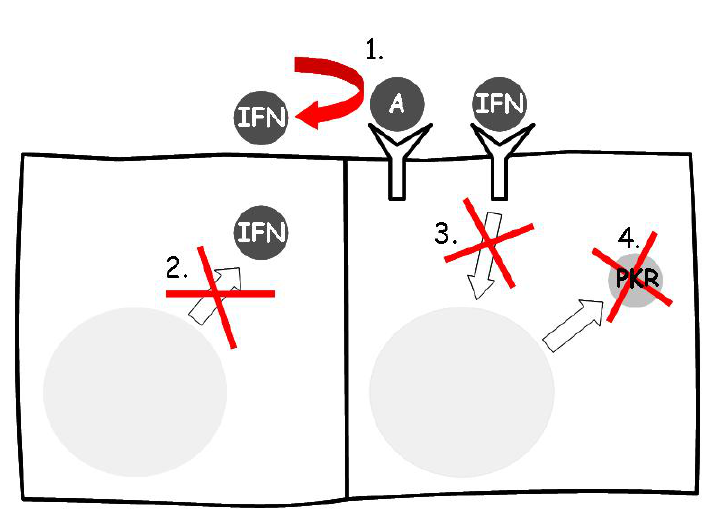
Figure 5. Mechanisms by which viruses circumvent the effect of IFN. 1. Competition with IFN for receptors (IFNAR); 2. Inhibition of IFN synthesis and secretion; 3. Inhibition of the IFN signaling, which may happen at different levels; 4. Inhibition of the proteins stimulated by IFN, mostly of the PKR